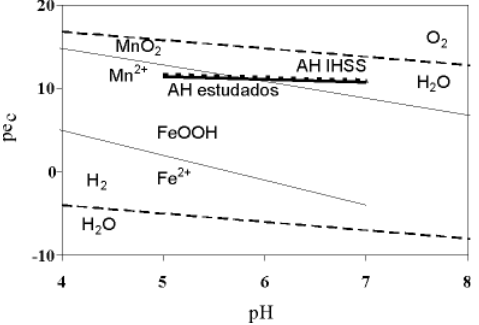
Figura 3. Diagrama pe vs pH, mostrando pares redox comuns em sistemas naturais e AH isolados de adubos orgânicos e de amostras-padrão da IHSS (Struyk & Sposito, 2001). Adaptado de Bartlett & James